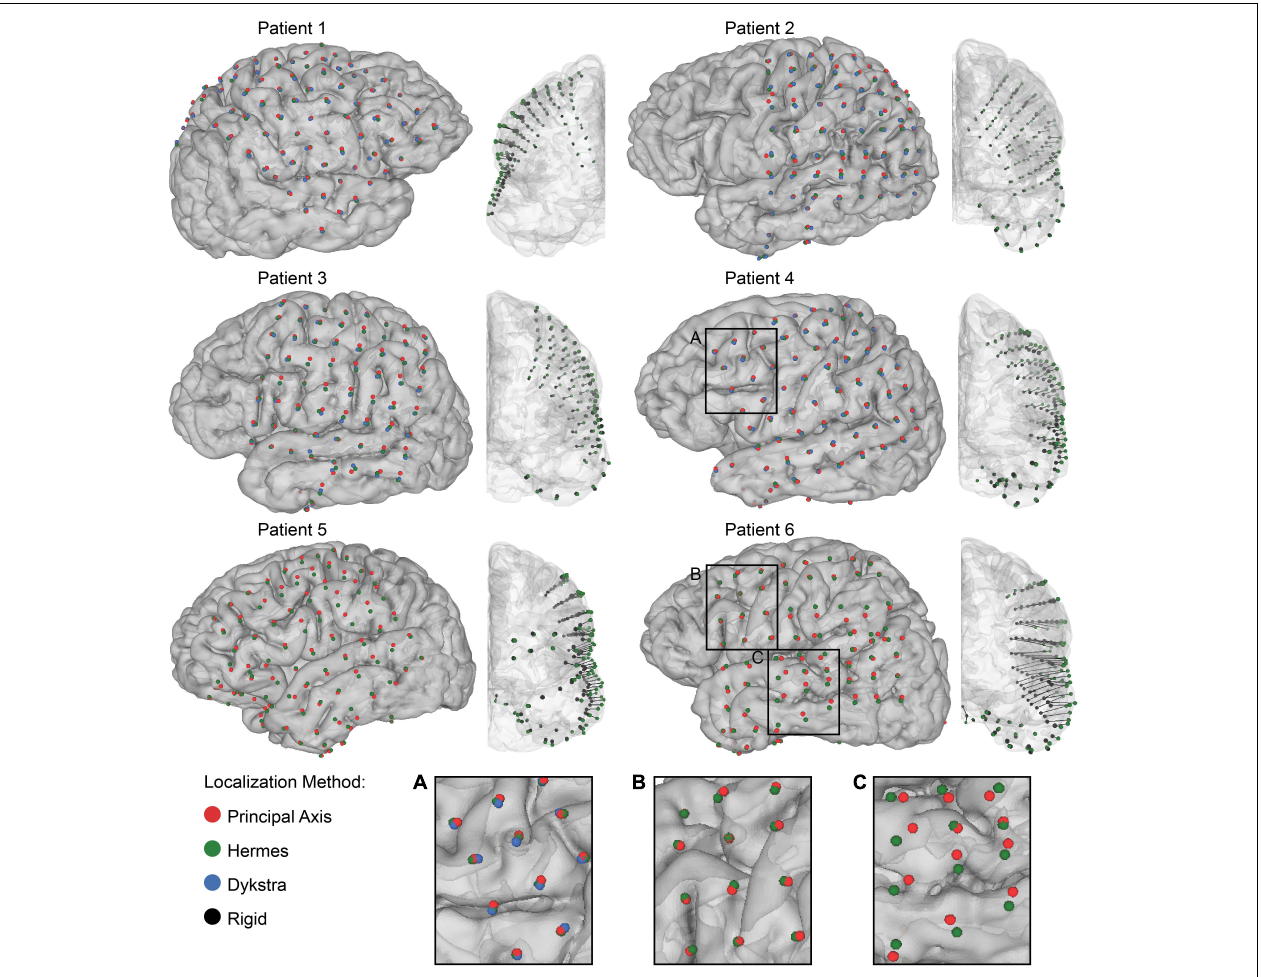
FIGURE 3 | Electrode localization and quantification of brain shift. Final electrode localization for all projection methods for 0 mm CSF depth in each patient. The centroids indicate the final electrode localization on the patient-specific gray matter surface: principal axis (red), Hermes (green), and Dykstra (blue) ( left ) and the anterior view of the rigid electrode localization from the CT (black) with a vector to the projected Hermes localization on the gray matter surface ( right ). Both strip and grid ECoG electrodes are shown. Note that the Dykstra method did not converge for patients 5 and 6. Across projection methods, the centroid locations were similar for many of the patients (A) , but varied in others by converging (B) , and diverging (C) in separate brain